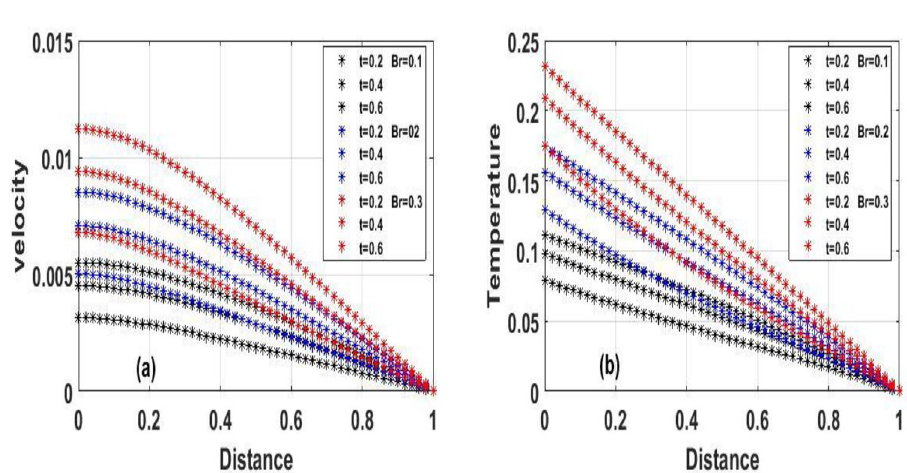
Figure 6. The effect of variation of Br for Temperature and velocity unsteady